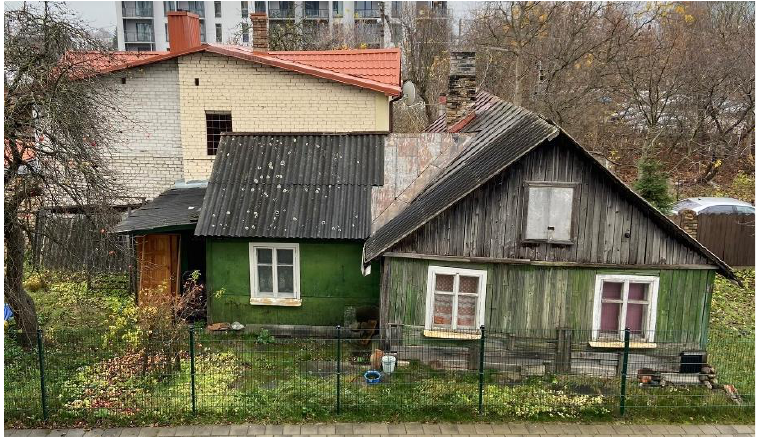
Figure 8. Building in green color: wall — metal sheet, wooden cladding, roof — asbestos, rolled tin. Building in white color: wall — bricks, roof —steel. Photo by A. Gabrėnas.